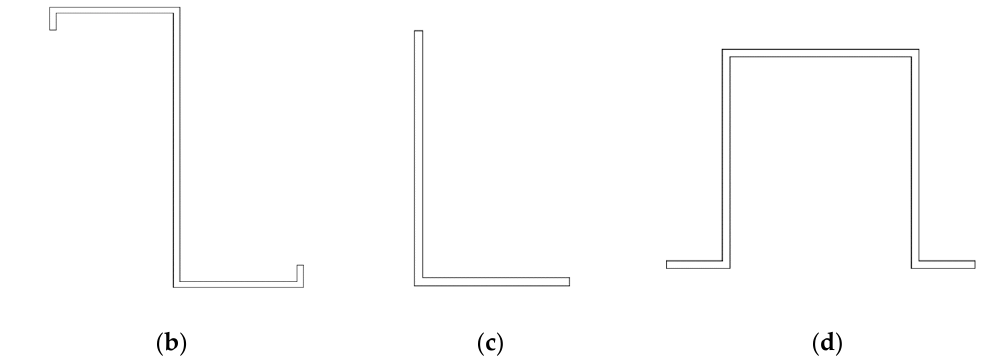
Figure 1. Cross sections of a typical ( a ) “C” shaped section; ( b ) “Z” shaped section; ( c ) “L” shaped section; ( d ) Hat-shaped section.